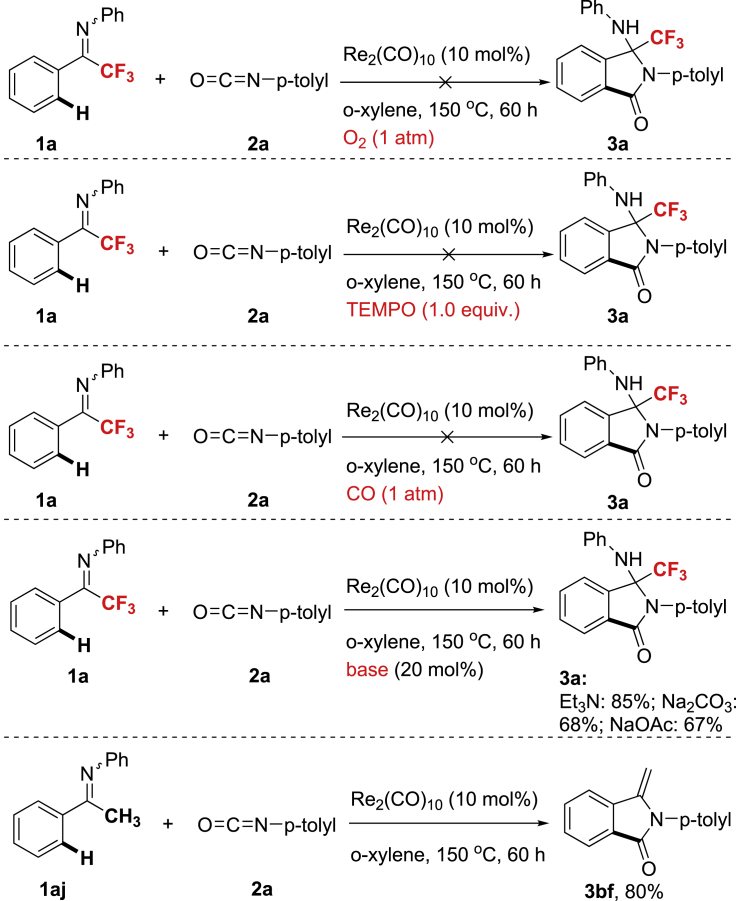
Control Experiments